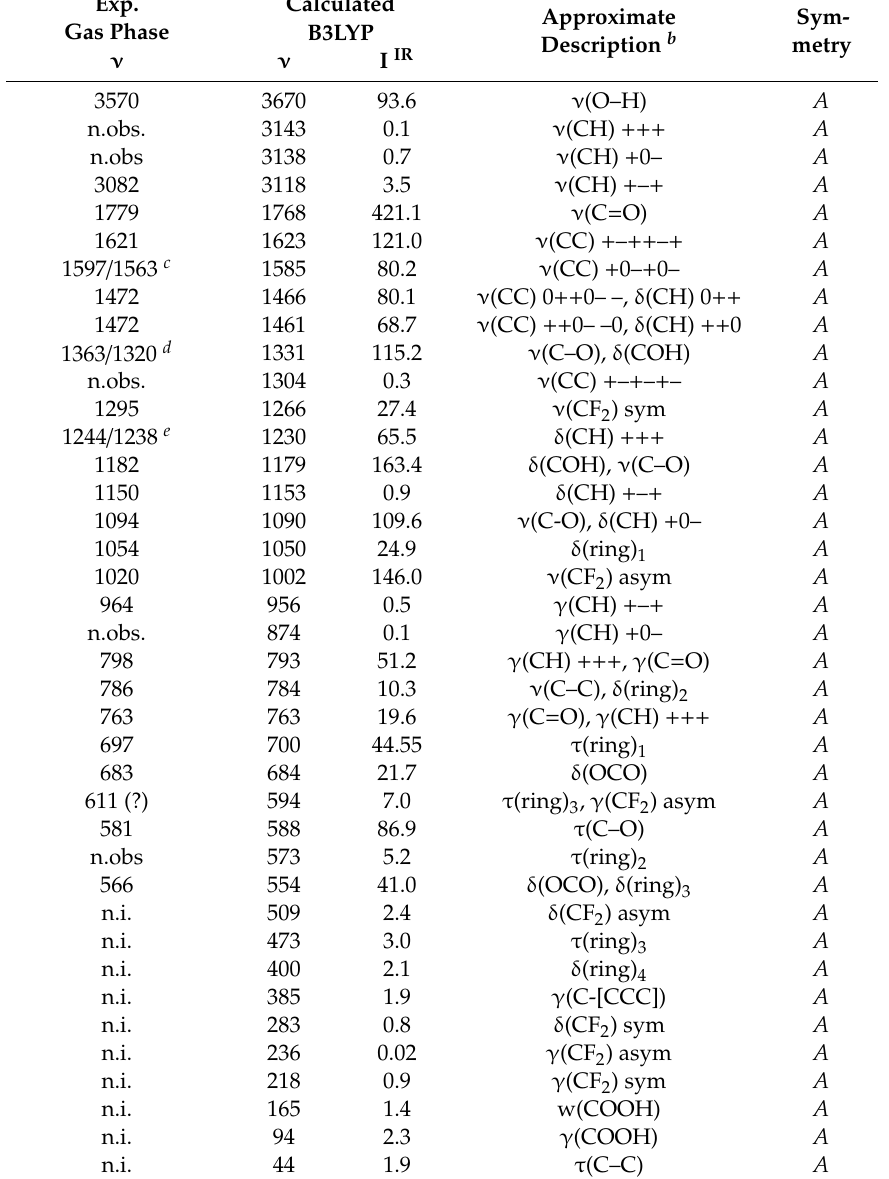
Table 5. Experimental (Exp.) and B3LYP / 6-311 ++ G(d,p) calculated (Calc.) infrared spectra of monomeric 2,6-difluorobenzoic acid, and band assignments a